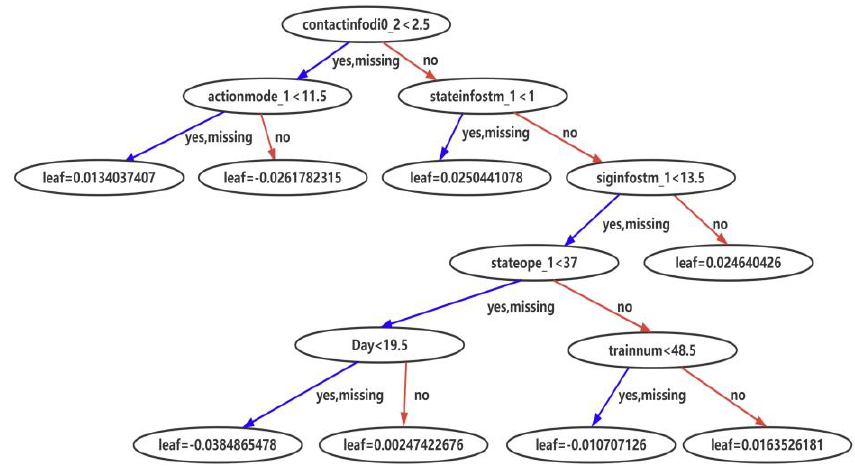
Figure 12. Typical sub-model (tree) of the ensemble by the training with 2018-T(B).